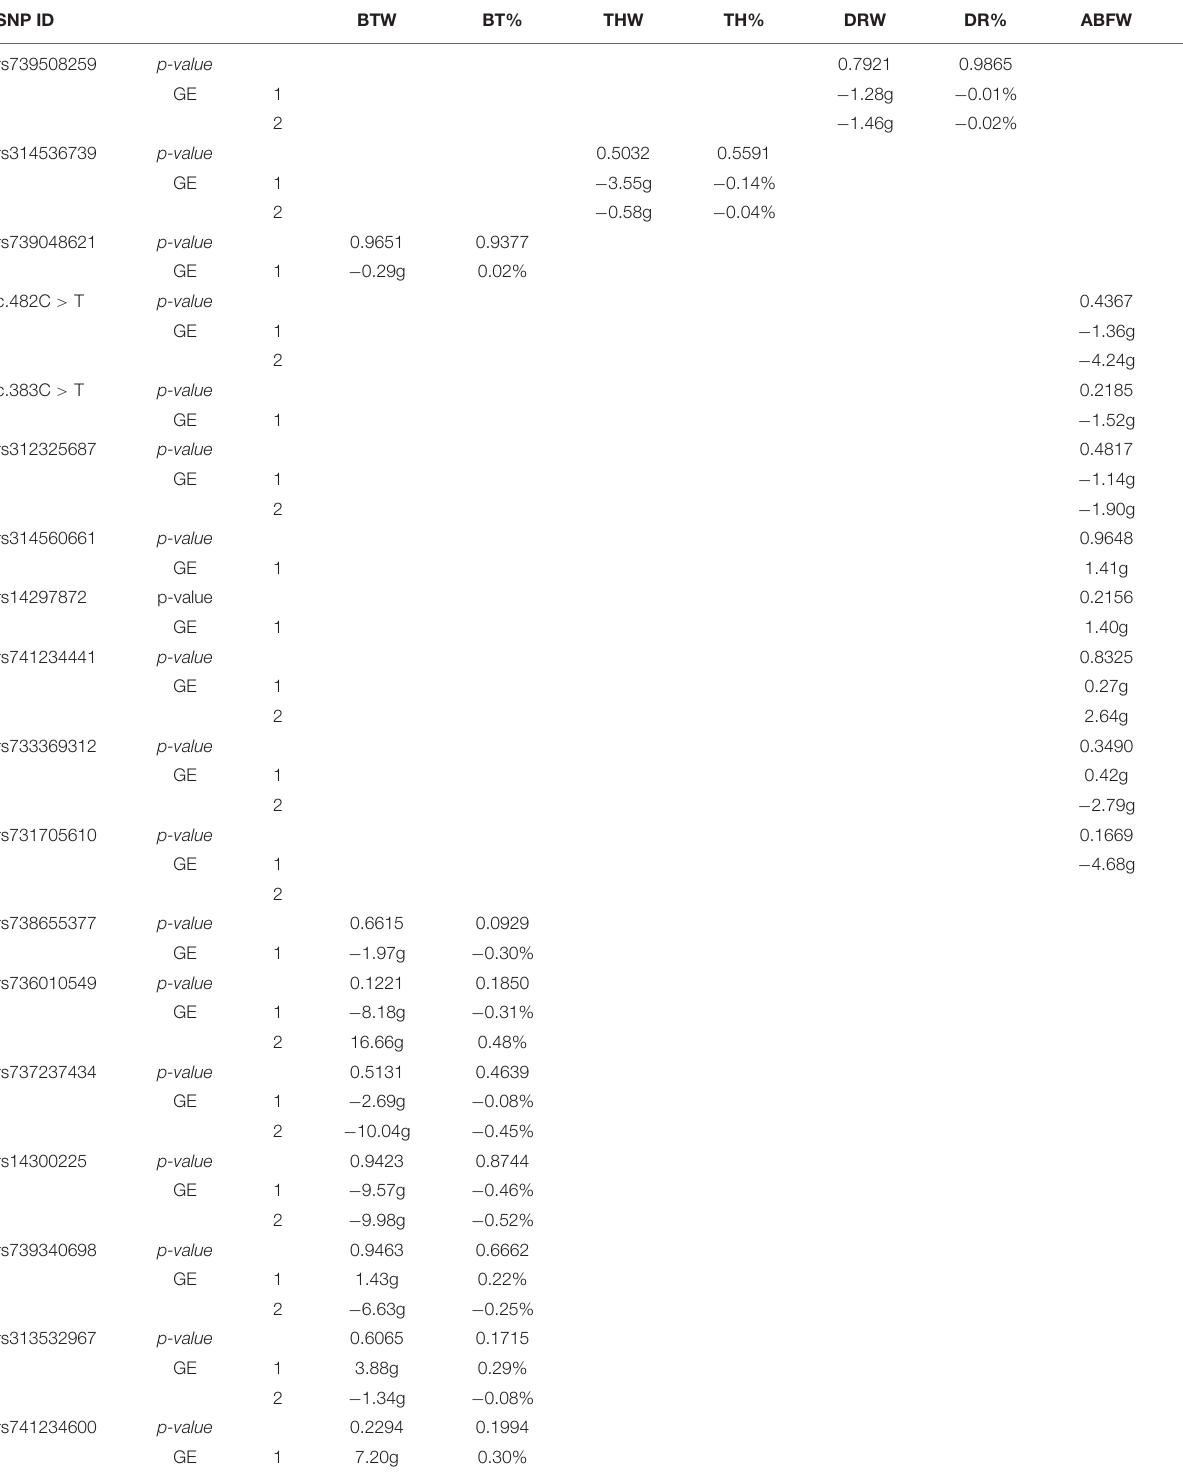
TABLE 6 | Association analysis results ( p-values ) for dominance effects based on a non-additive model applied to carcass